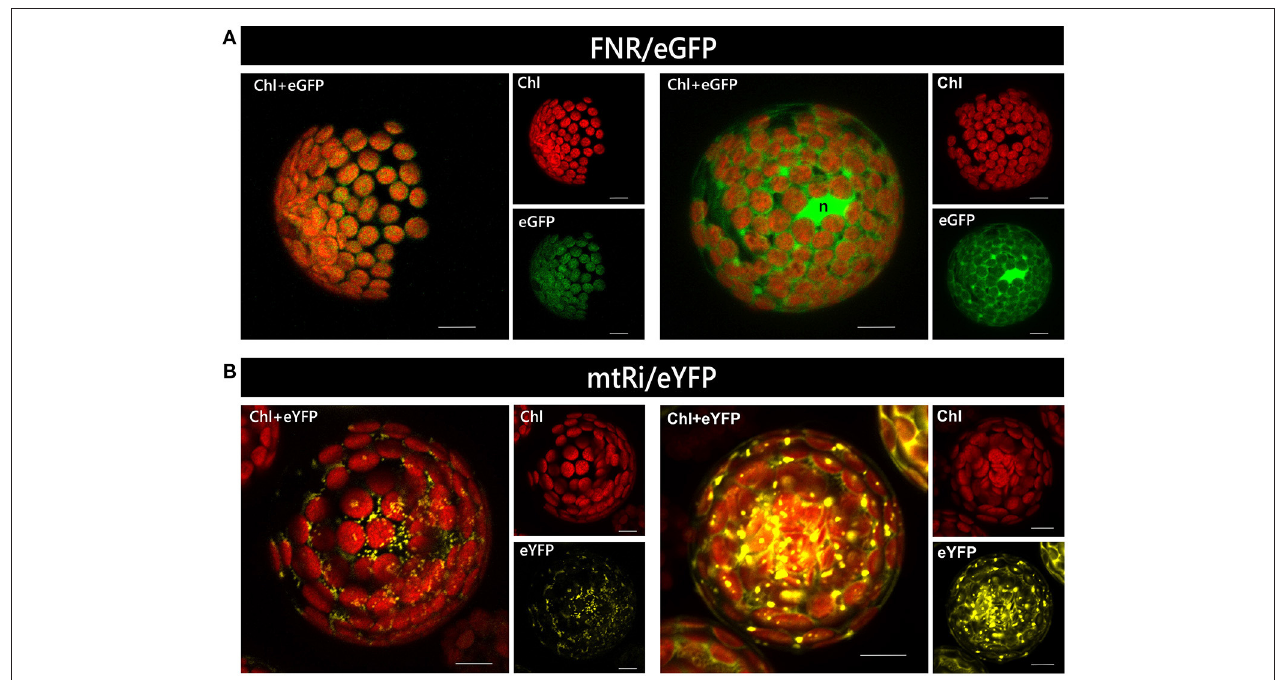
FIGURE 4 | Relationship of expression rate and mislocalization in isolated protoplasts. Protoplasts isolated from leaves of Arabidopsis thaliana were transiently transformed with constructs encoding either FNR/eGFP (A) or mtRi/eYFP (B) , which usually leads to the accumulation of the reporter in chloroplasts and mitochondria, respectively ( left panels ). However, at high expression levels FNR/eGFP is often found predominantly in the cytosol rather than in plastids, while mtRi/eYFP is found accumulating as aggregates ( right panels ). All images are maximum intensity projections of several single images representing the complete protoplast in z-axis. The bright green area found in the right panel of image (A) probably represents the nucleus ( n ). For further details see the legend of Figure 1